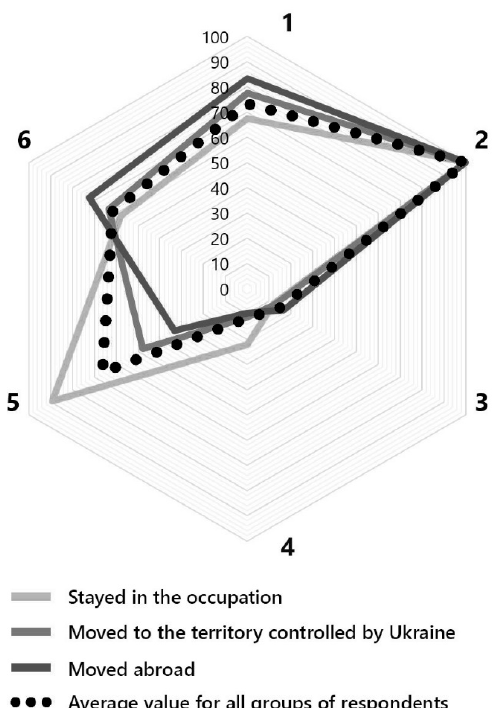
Figure 8. Subjective assessment of scientific activity by university